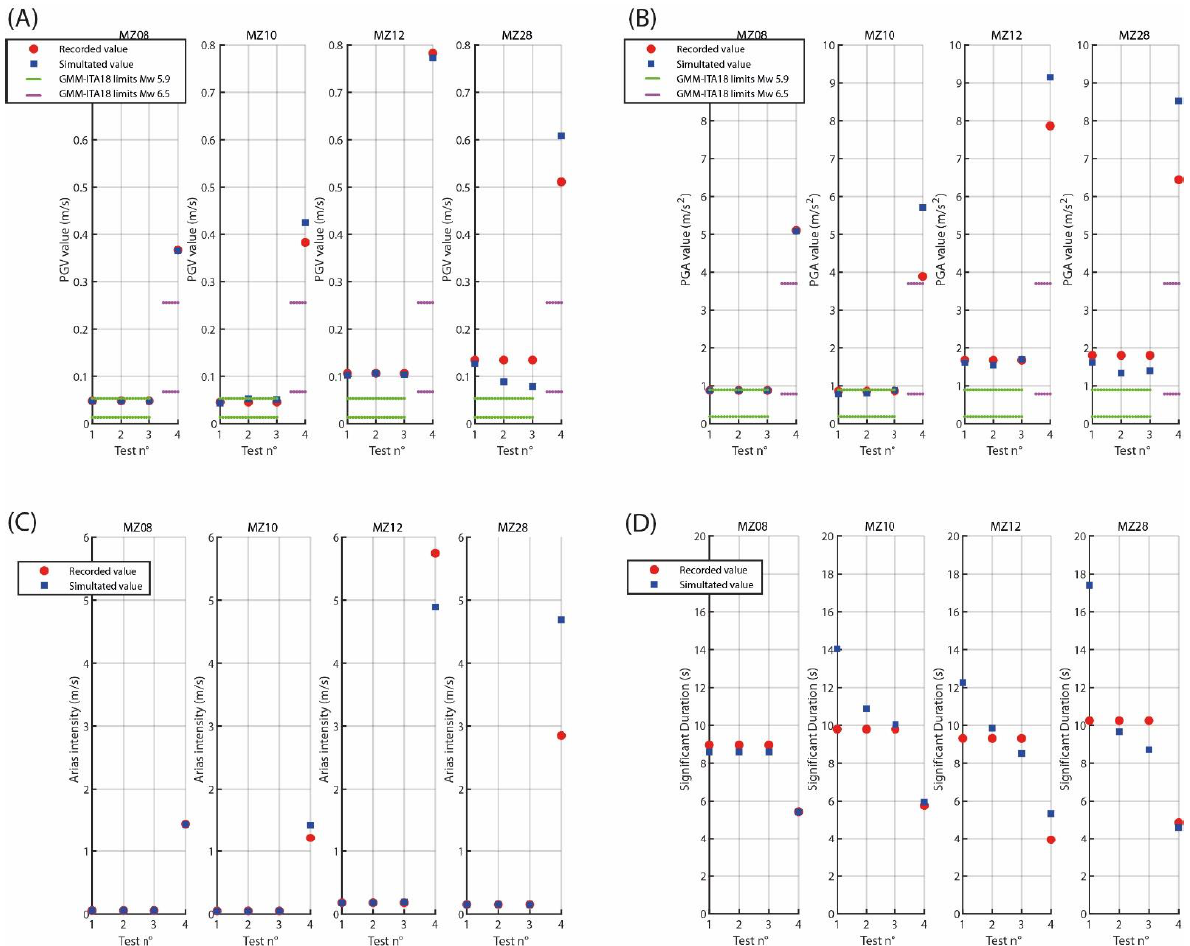
Figure 6. Comparison of the maximum horizontal intensity measures of the recorded (red) and simulated (blue) seismograms at MZ08-10-12-28 for the four tests: ( A ) PGV; ( B ) PGA; ( C ) Arias intensity (AI); ( D ) significant duration (SID). The green and magenta lines represent the GMM values ± 1 standard deviation [49], for class B site (Vs30 = 670 m/s at AMT) and for the following coupled magnitude Joyner – Boore distance (Rjb): Mw 5.9 and Rjb = 25km (26 October 2016; test 1 and 2), Mw 6.5 and Rjb = 10.1km (30 October 2016; test 3 and 4) [38].